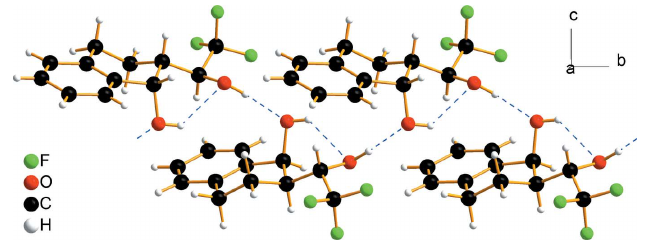
Figure 2 Helical hydrogen-bonded chain extending parallel to [010] that involves intermolecular and intramolecular O—H (cid:2)(cid:2)(cid:2) O hydrogen bonds, which are indicated by blue dashed lines.